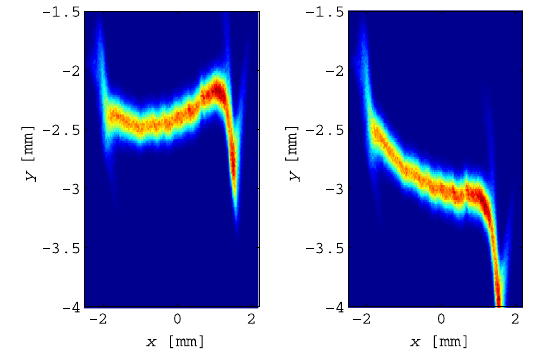
FIG. 11. Projected emittance increase for different combina- tions of the two dechirper sections. “ V ” means vertical dechirper and “ H ” means horizontal